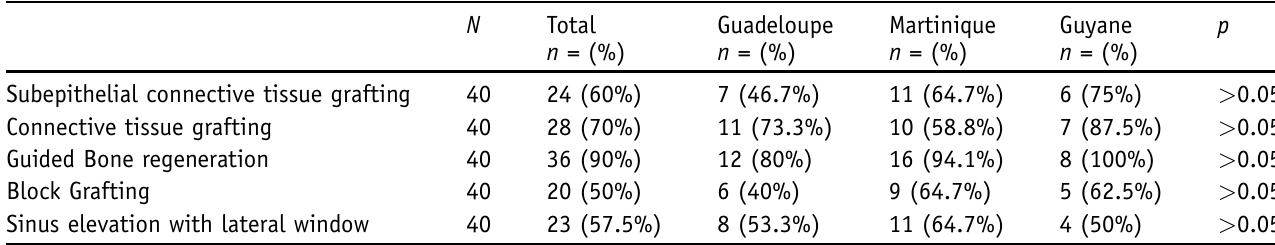
Table 4. Grafting procedures of dentists in Guadeloupe, Martinique and French Guyana.